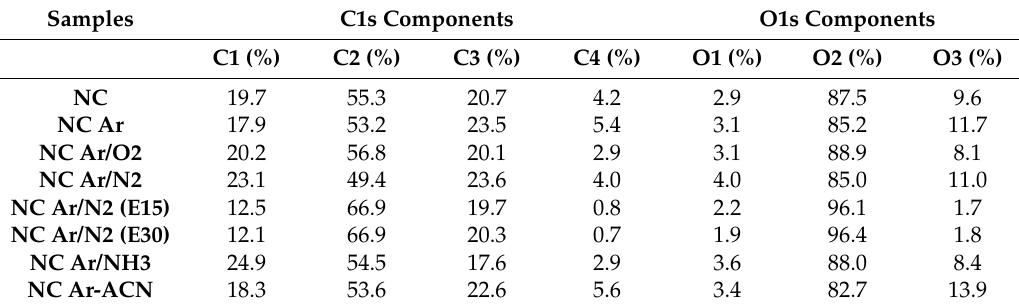
Figure 9. High resolution N1s spectra with deconvolution (different colored N1–N4 components) of pristine NC ( a ); NC Ar/N 2 (E30) ( b ); NC Ar/NH 3 ( c ), and NC Ar-ACN sample ( d ).